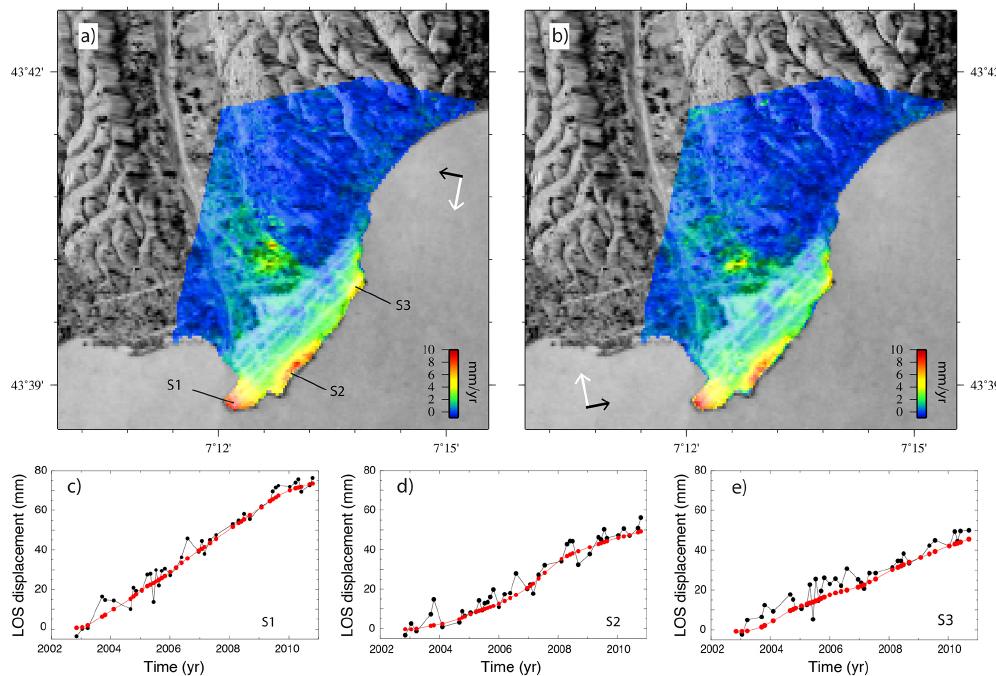
Figure 3. Ground velocity maps from InSAR time series analysis in mmyr − 1 measured along the satellite line of sight (LOS) direction (black and white arrows show the LOS and flight directions, respectively). For descending track 22 (a) and ascending track 301 (b) , velocities are shown positive in the direction away from the satellite (black arrows). Time series of the ground displacement (shown in c – e ) for three pixels located in S1, S2, and, S3. Black and red lines represent the ground displacement between 2003 and 2011 without or with smoothing,